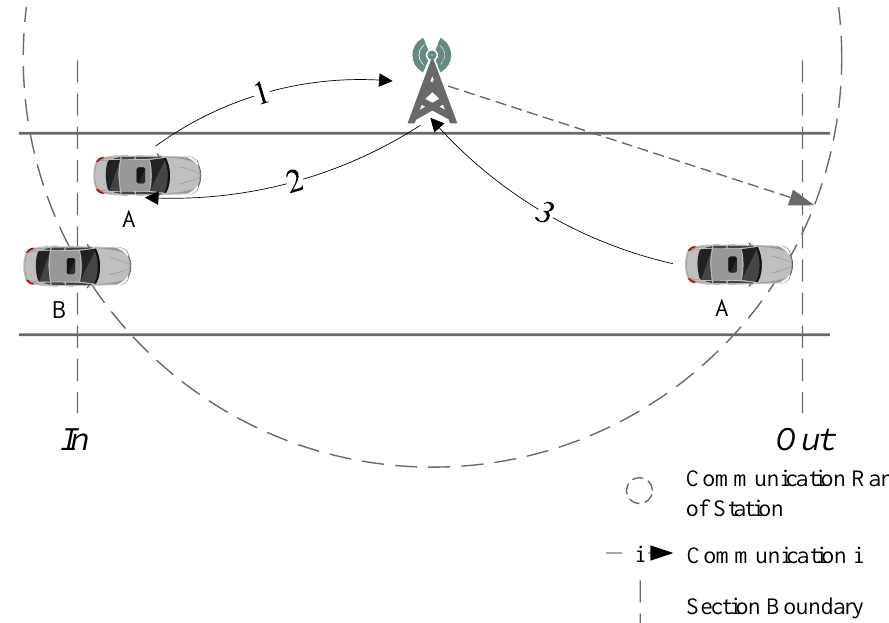
Figure 3. Workflow of New Vehicle Registering at Base Station and Uploading CSI to